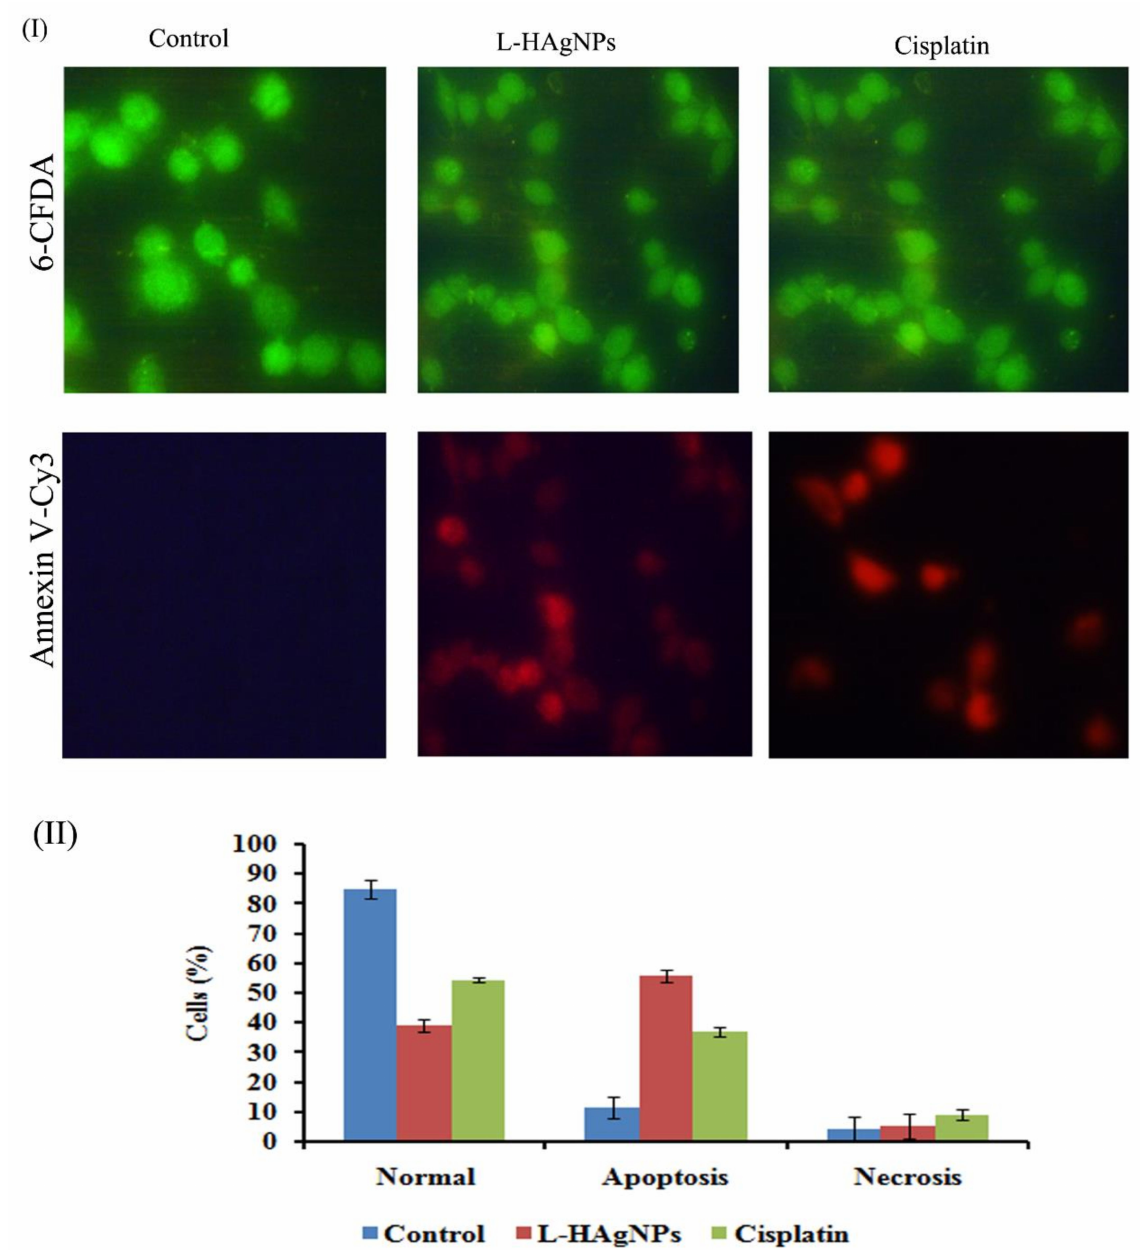
Figure 8. Assessment of L-HAgNPs induced apoptosis in cervical carcinoma cells (SiHa) by annexin-Cy3 (red) and 6- CFDA (green) dual staining ( I ) Fluorescence microscopic image representing apoptotic (green) and healthy cells (red); ( II ) percentage of apoptotic